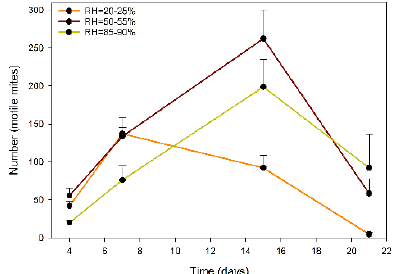
Figure 3. Total numbers of motile mites/sachet (means) of the predatory mite Amblyseius swirskii (immature motile and adult) that hatched from the slow-release sachets in periods of 0–4, 5–7, 8–15 and 15–21 days at the following RH levels in a laboratory trial conducted under controlled conditions (temperature = 25 ± 1 °C): low (22.5 ± 2.5%), medium (52.5 ± 2.5%) and high (87.5 ± 2.5%) (whiskers show the SE values).